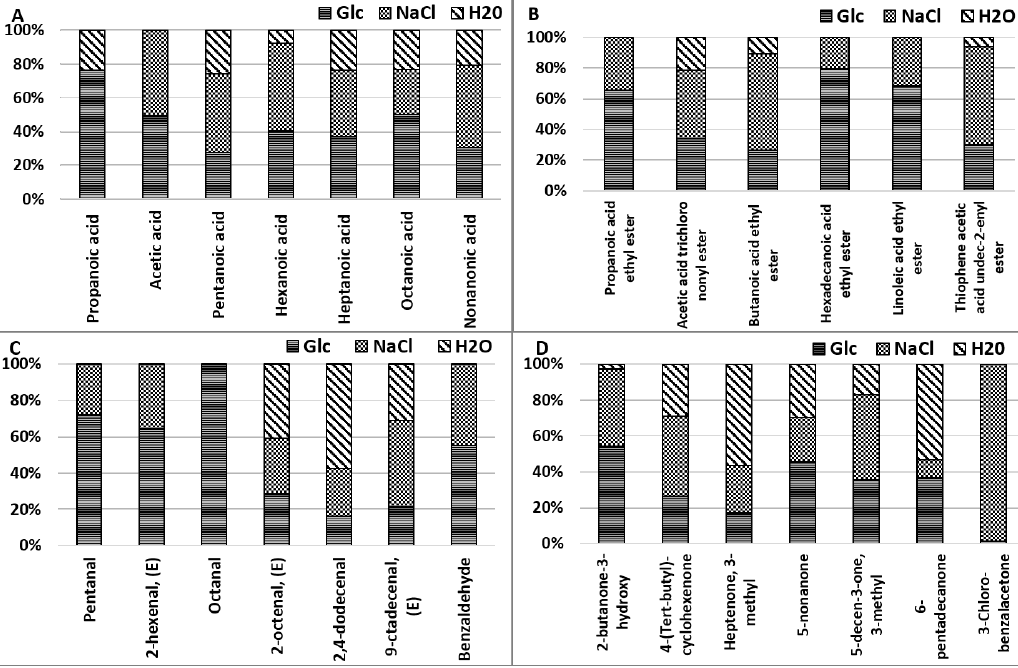
Figure A3. ANOVA plots with categorical predictors set on the presence or absence of NaCl ( P < 0.01), relative to; ( a ) organic acids; ( b ) esters; ( c ) aldehydes; ( d ) ketones. F = not-inoculated leavened doughs; Glc = leavened doughs added with glucose; NaCl = leavened doughs added with NaCl; H 2 O = leavened doughs not inoculated and without glucose or NaCl.